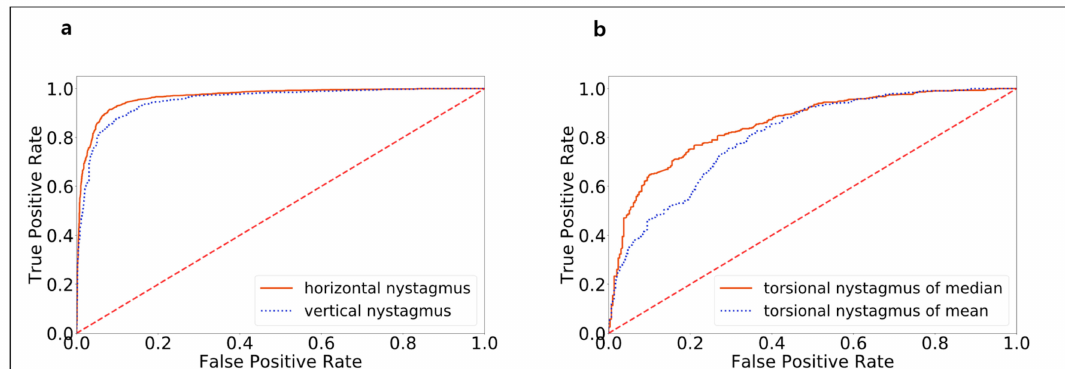
Figure 4. The receiver operating characteristic curve (ROC) of model performance in classifying nystagmus types after model training. The areas under ( a ) the ROCs for measuring horizontal and vertical nystagmus were 0.966 and 0.952, respectively, and the area under ( b ) the ROC for measuring torsional nystagmus was 0.853. When overall torsion was calculated using mean sample distance, the area under of the ROC was 0.807 due to outlier e ff ects.